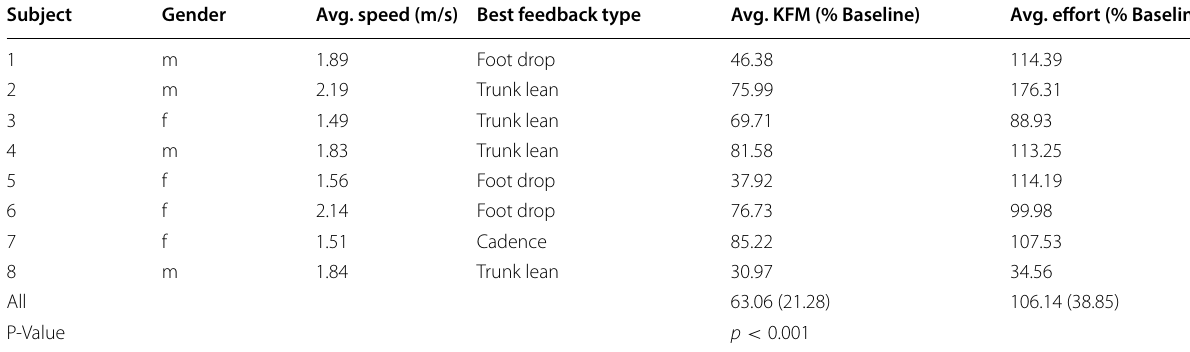
Table 2 Results for all subjects by single feedback type